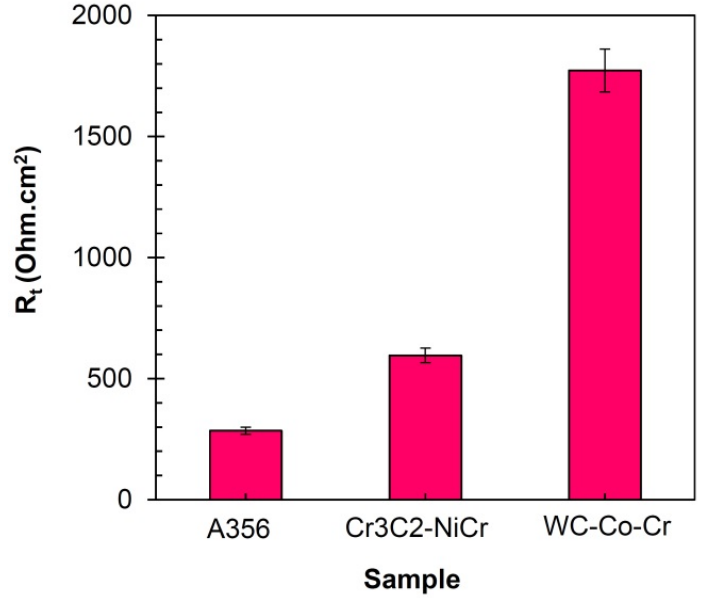
Figure 21. Resistance changes of the investigated samples.